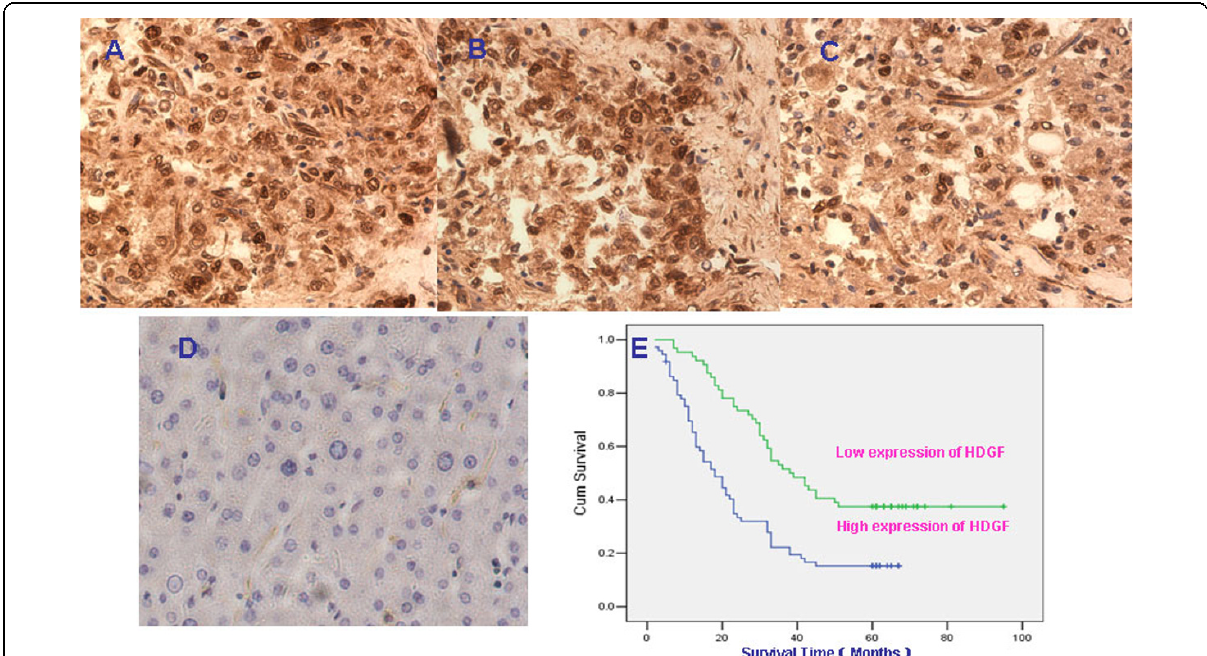
Figure 1 Detection of HDGF protein in HCC and Kaplan-Meier plots of overall survival duration in patients with HCC . HDGF protein expression in HCC and normal liver samples. A and B . Strong expression of HDGF in HCC samples. C . Weak expression of HDGF in HCC samples (original magnification 400×). D . Negative expression of HDGF in liver sample; E . Kaplan-Meier survival analysis of overall survival duration in 137 HCC patients according to HDGF protein expression. The log-rank test was used to calculate p